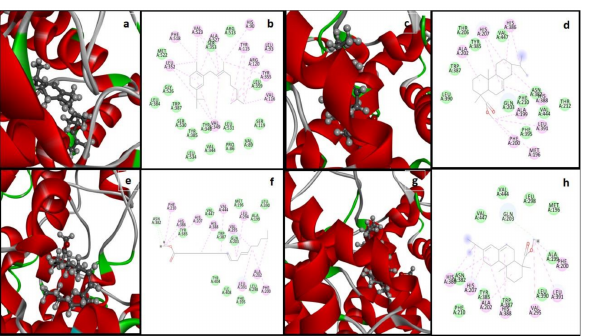
Figure 5. Four compounds ((( 41 ) a , b ), (( 47 ) c , d ), (( 44 ) e , f ), and (( 49 ) g , h )) with the highest dock score represent the best binding poses within the active binding site of Cyclooxygenase-2 (COX-2) protein (PBD ID: 5KIR). Three-dimensional view of the best-bounded conformation of docked ligands ( a , c , e , g ) and a two-dimensional plot showing significant protein-ligand binding interactions (green colored circles present Van der Waals interactions and carbon-hydrogen bond, while purple-colored circles present alkyl and Pi-alkyl interactions) ( b , d , f , g ).